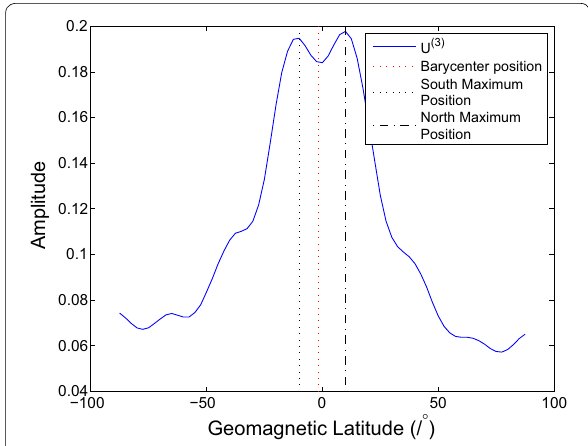
Fig. 9 Large-scale latitudinal variations in the ionosphere in geo- magnetic coordinates during the geomagnetic quiet time. The red, black dotted, and black dotted dash lines indicate the positions of the barycenter, and south and north maximum of U ( 3 ) , respectively. The x-axis is the geomagnetic latitude ranging from − 87.5 ◦ to 87.5